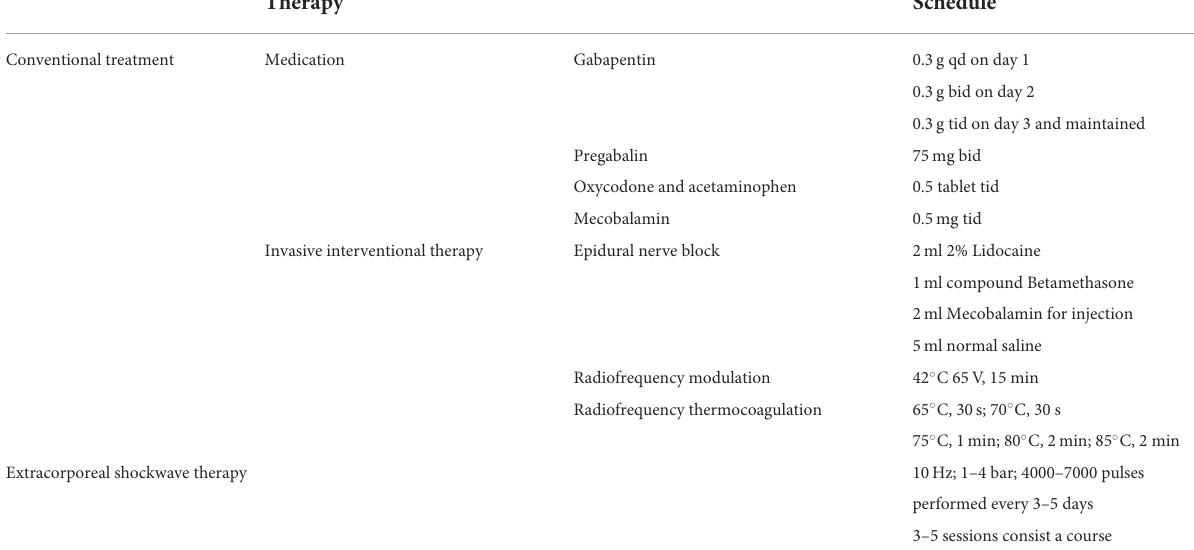
TABLE 1 Therapeutic